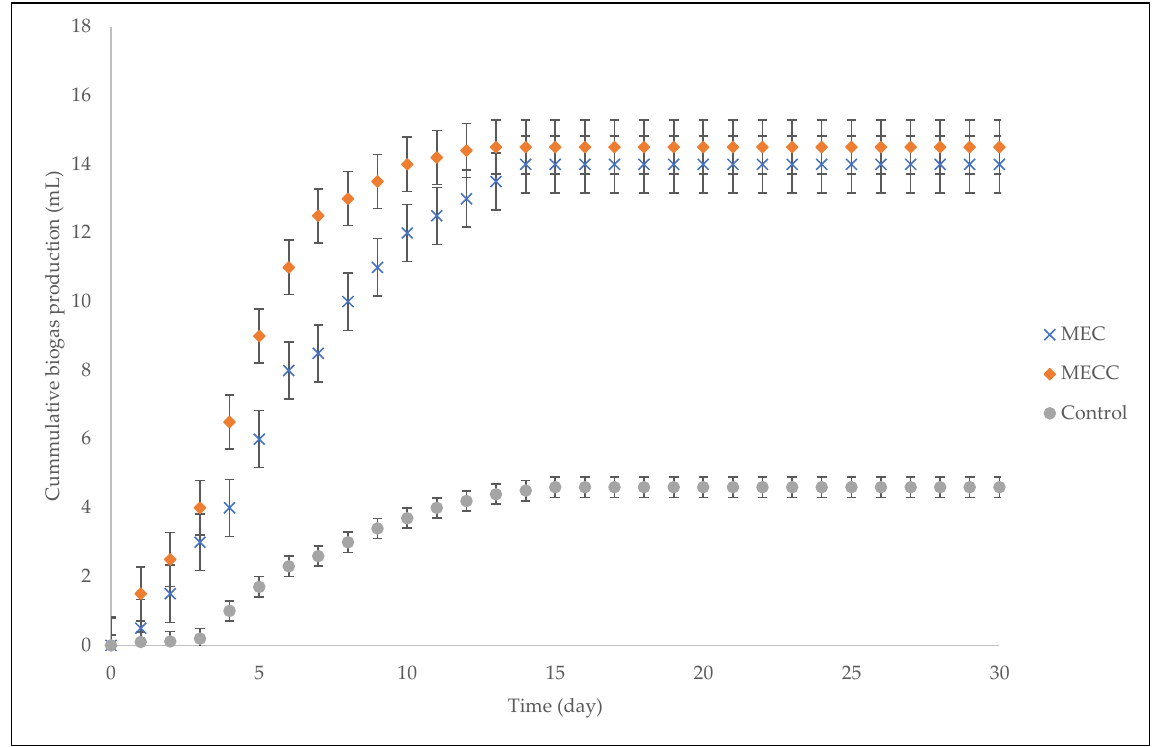
Figure 1. Cumulative biogas production.